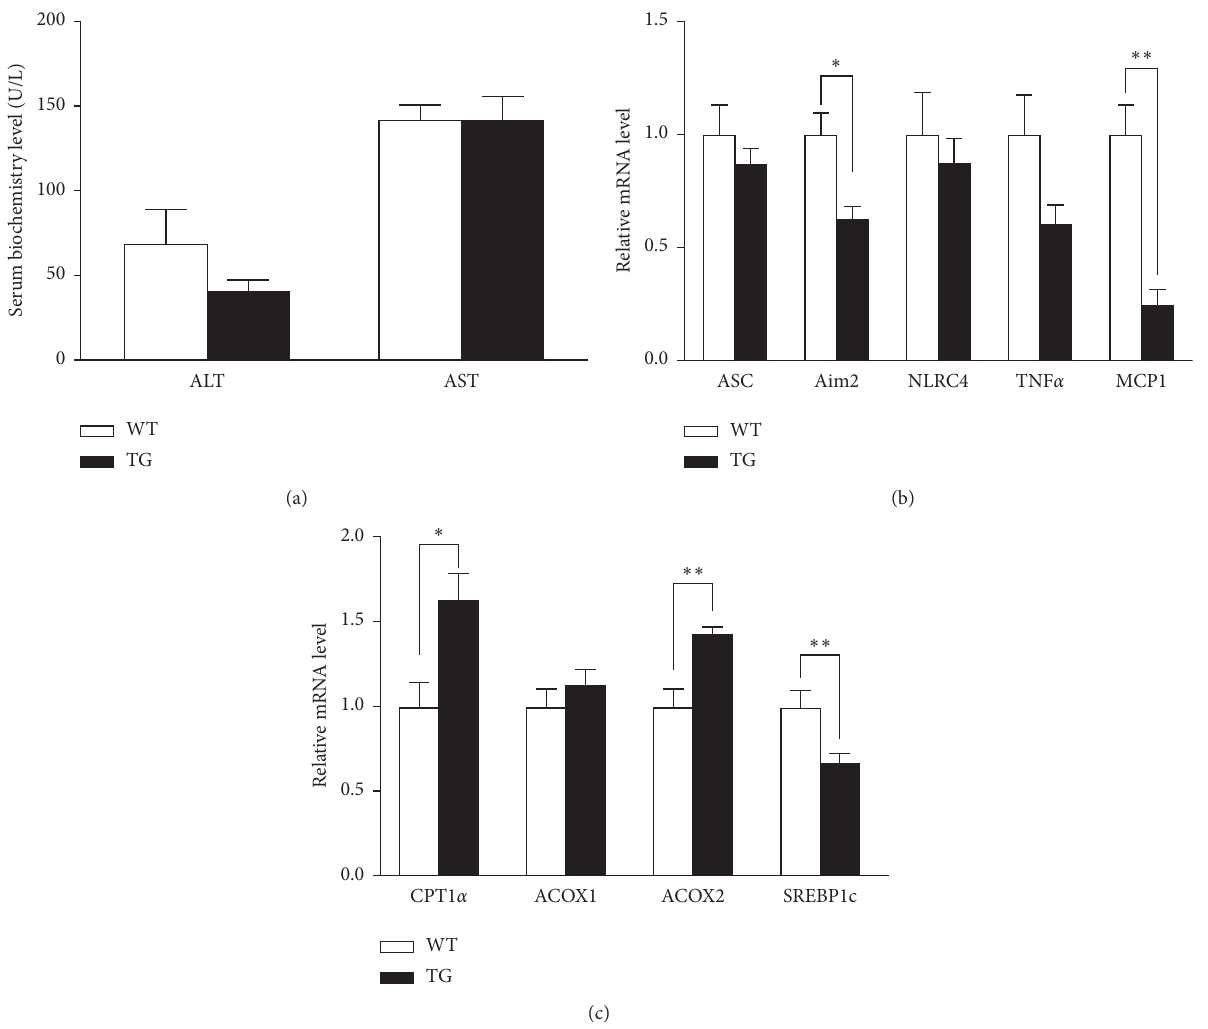
Figure 2: Biochemical markers of fatty liver and liver inflammation in GDF5 transgenic mice. (a) Fasting plasma ALTand AST levels after HFD feeding for 10 weeks. (b) The expression of inflammatory markers in the livers of WTand TG mice. (c) The expression of key enzymes associated with fatty acid oxidation in the WT and TG groups ( ∗ : P < 0 . 05; ∗∗ : P < 0 .